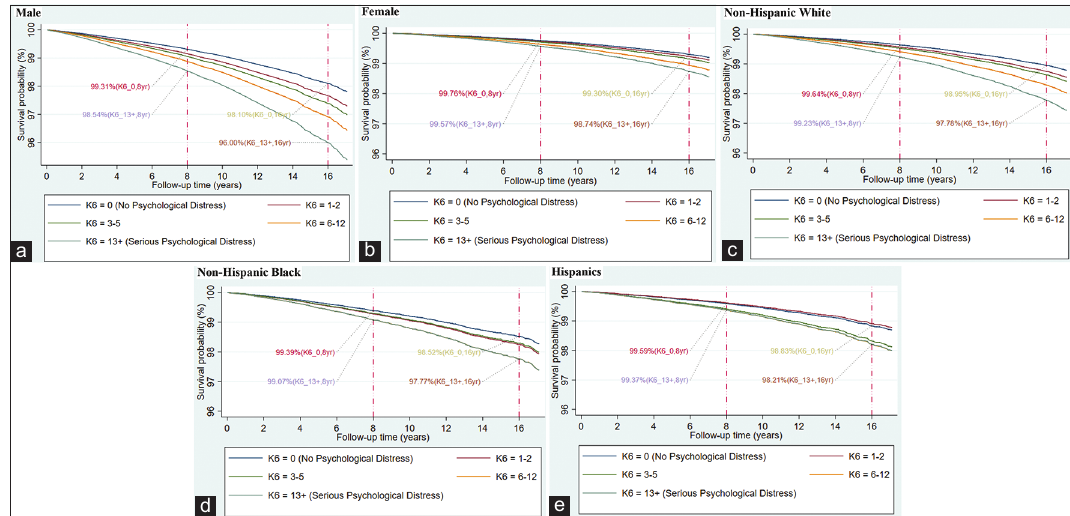
Figure 1: (a-e). Adjusted Survivorship of US Adults Aged ≥18 Years by Psychological Distress Level (K6 Scores) and Sex or Race/ethnicity, 1997-2014 (derived from estimated Cox models of heart disease mortality adjusted for socioeconomic and demo - graphic